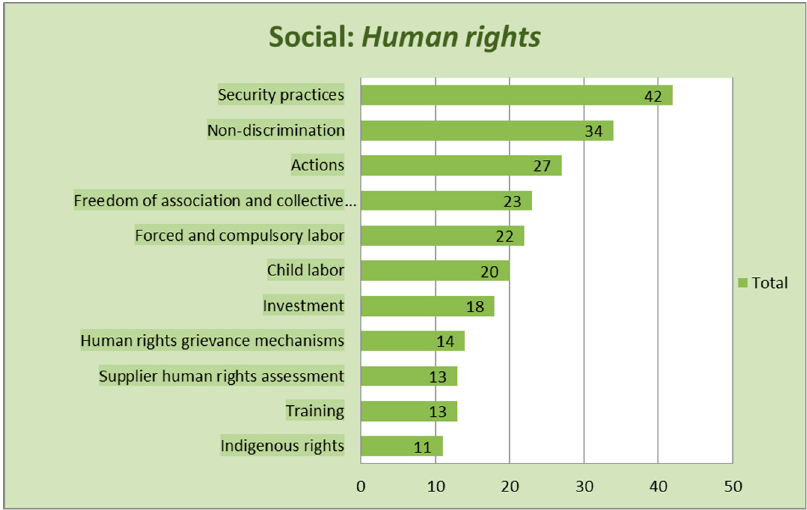
Figure 2. Tallies of occurrence of the social sustainability indicators from the human rights category.